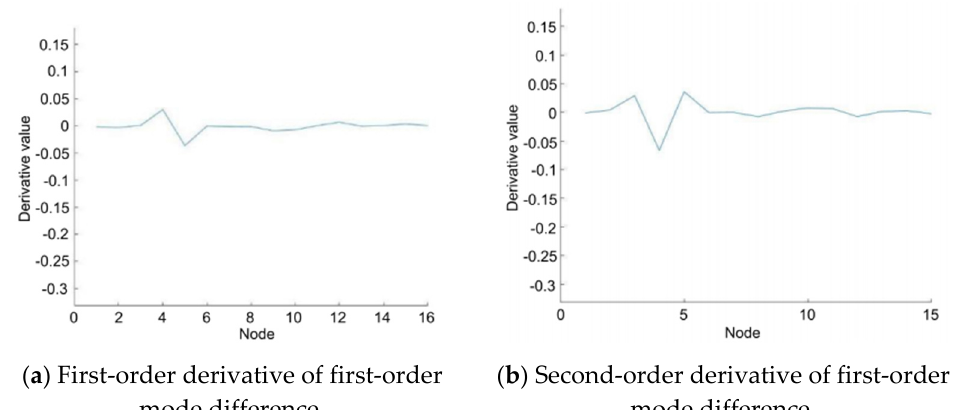
Figure 15. First-order and second-order derivative curves of the differences of the first five orders of modes under Conditions 1 and 2.